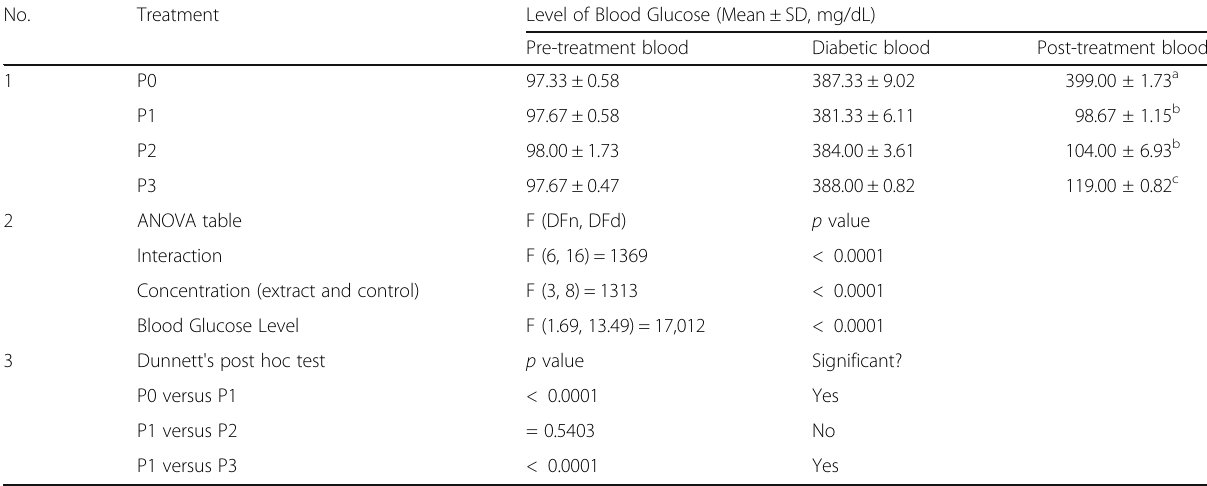
Table 2 Effect of the phenolic extract of the P. emblica flesh on the blood glucose level of the glucose induced rats No.